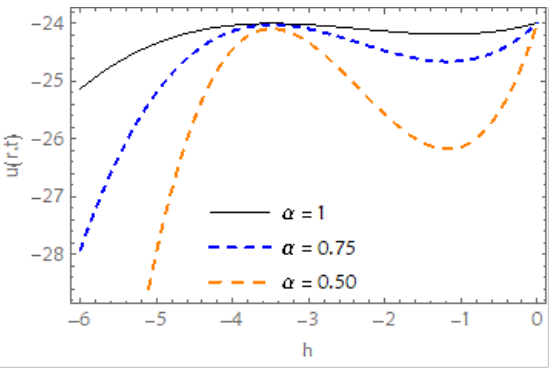
Fig. 8: α -curve of solution u ( r , t ) Vs. t when P = 1, (cid:126) = −1, n = 1, r = 1.5 for Ex. 4.2.